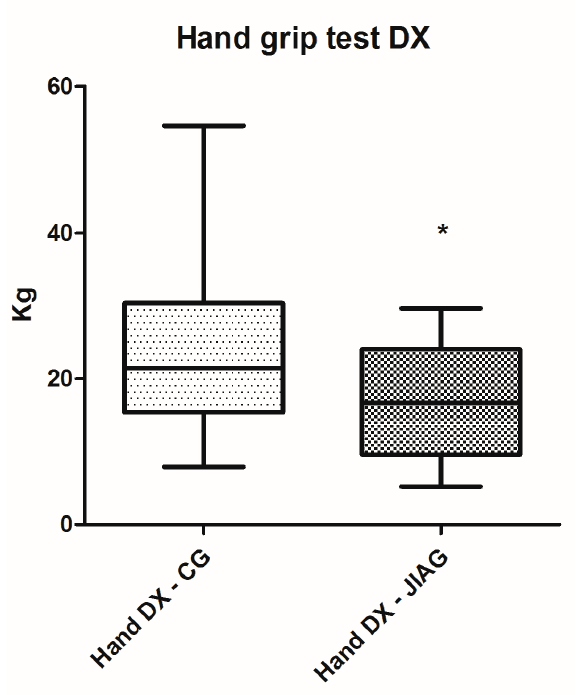
Figure 4. Analysis of hand grip (DX) performances among the group of the healthy subjects (CG) and subjects with juvenile idiopathic arthritis (JIAG). * indicated that p < 0.05. Int. J. Environ. Res. Public Health 2017 , 14 , 806